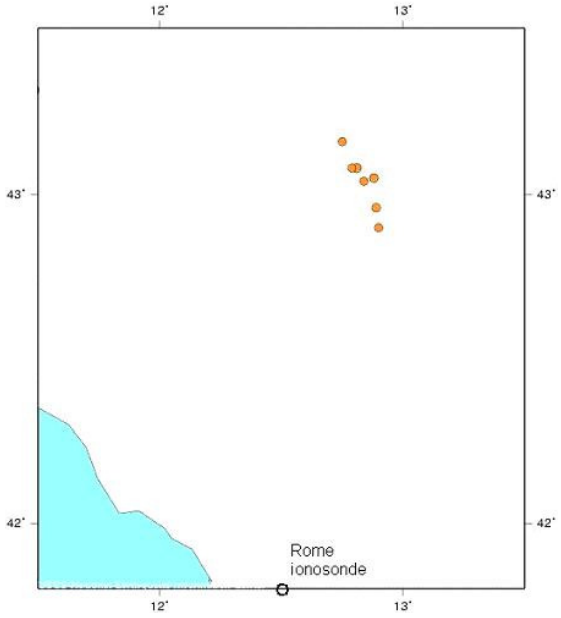
Fig. 1. Fig. 1. Map of M> 5 earthquakes occurred in Central Italy in September and October 1997.